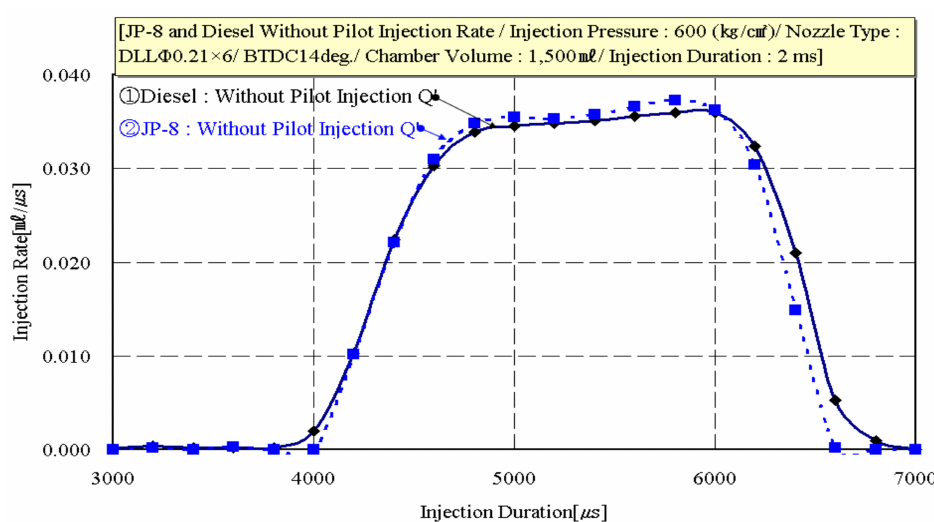
Figure 9. Injection rate characteristics during injections of diesel and JP-8 without pilot injection.